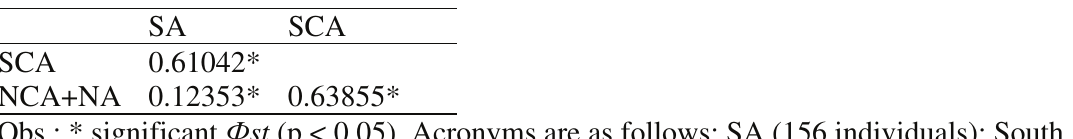
Table S4 - Pairwise Ф st values among subcontinental groups groups of Puma concolor , estimated on the basis of p-distances (see text for